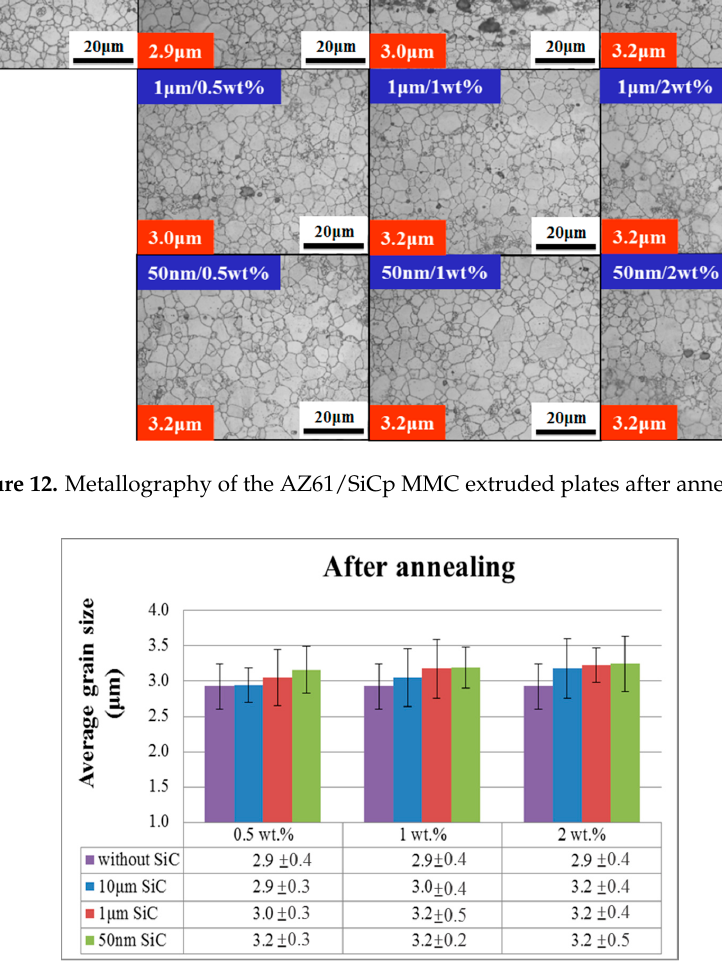
Figure 13. Average grain size of the AZ61/SiCp MMC extruded plates after annealing.